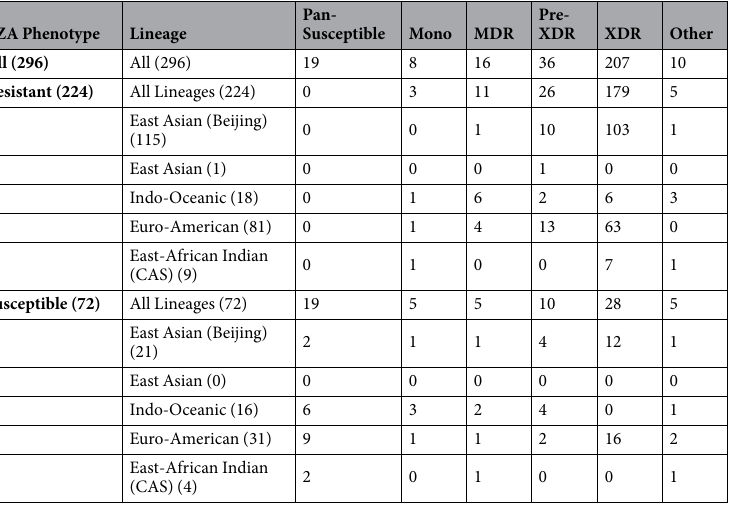
Table 1. Drug susceptibility patterns per lineage among the GCDD M. tuberculosis clinical isolates. Numbers in parentheses indicate total isolate counts for each category. PZA : pyrazinamide; MDR-TB: resistant to isoniazid and rifampicin, only; XDR-TB: MDR-TB that is also resistant to at least one fluoroquinolone and one injectable; pre-XDR-TB: MDR-TB and resistant to either a fluoroquinolone(s) or an injectable(s); Pan-Susceptible: susceptible to all seven (INH, RIF, CAP, AMK, KAN, OFX, MOX) drugs tested; Mono: isolates resistant to only one of the seven study drugs; Other: isolates with unusual phenotypic patterns such as susceptibility to INH but resistance to second line